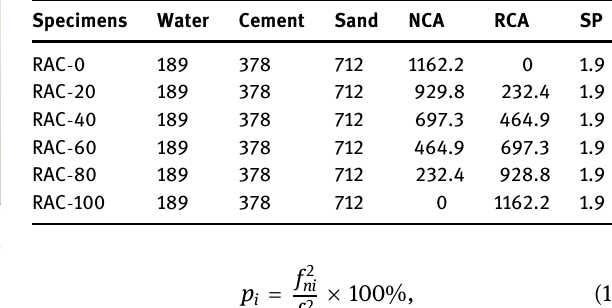
Figure 2: Appearance of coarse aggregates: ( a ) NCA and ( b ) RCA.